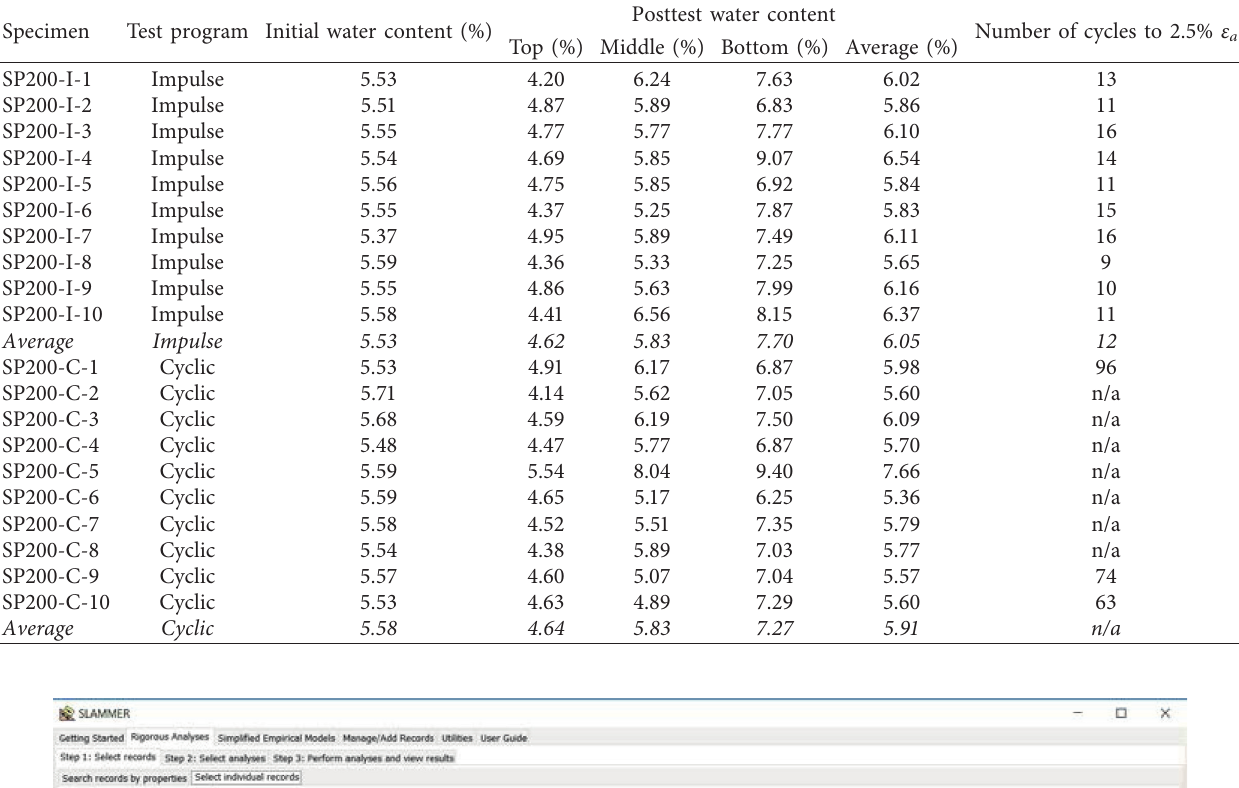
Table 2: Test results from equivalent cyclic and impulse loading [4].